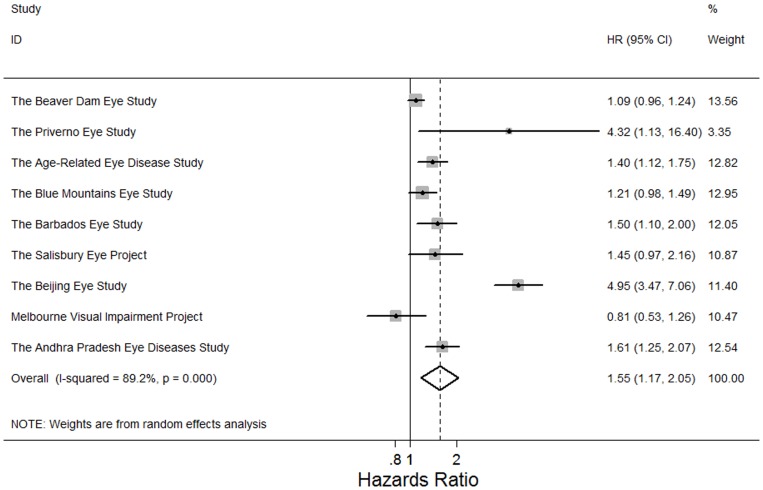
Random effects meta-analysis investigating the association between nuclear cataract and all-cause mortality.HR = hazards ratio; CI = confidence interval.